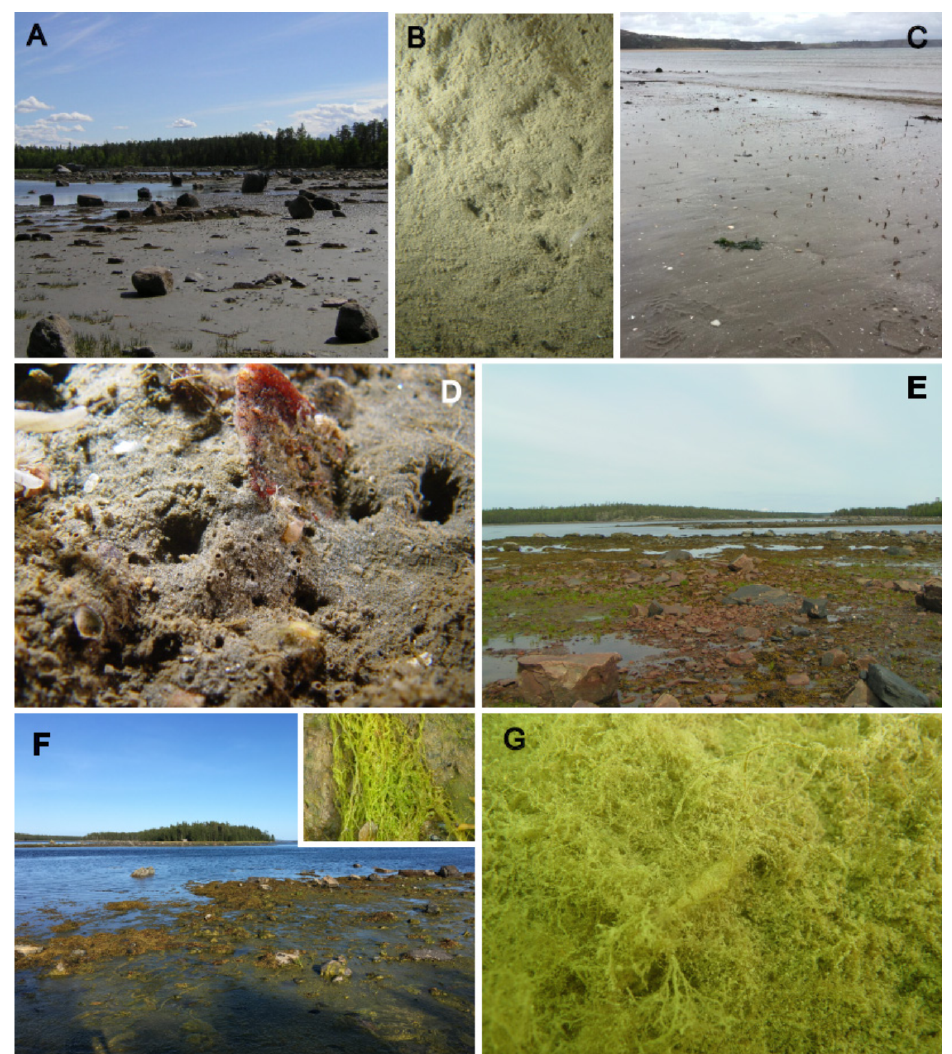
Figure 11. Photographs of some common and special habitats in Orbiniidae. ( A ). Muddy intertidal. ( B ). Muddy subtidal. ( C ). Sandy intertidal. ( D ). Sandy subtidal. ( E ) Mixed muddy/rocky intertidal. ( F ). Intertidal algal meadow, with detail on the algal species Ulva sp. ( G ). Subtidal algal meadow (different filamentous algae). All photos were taken from the White Sea, Russia, except C which was taken from Oxwich Bay,